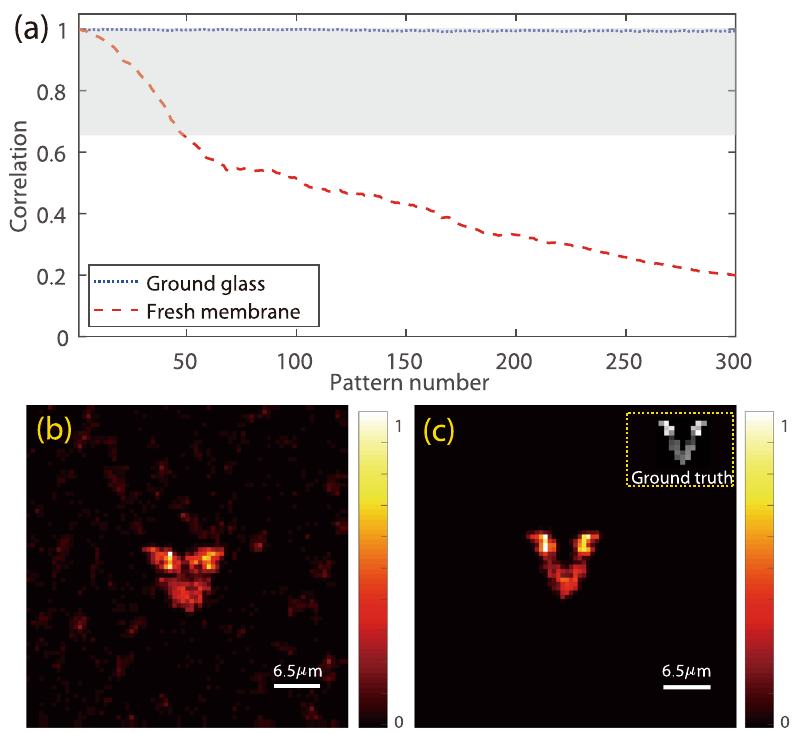
Fig. 5 Experimental demonstration of non-invasive super-resolution imaging through a fresh chicken eggshell membrane by SOSLI. a Speckle correlation of PSFs at different measurement time for the static scattering medium (ground glass) and the dynamic one (the fresh chicken eggshell membrane). b The reconstructed image by SOSLI with a single estimated PSF. c The reconstructed image by SOSLI with adaptive PSF